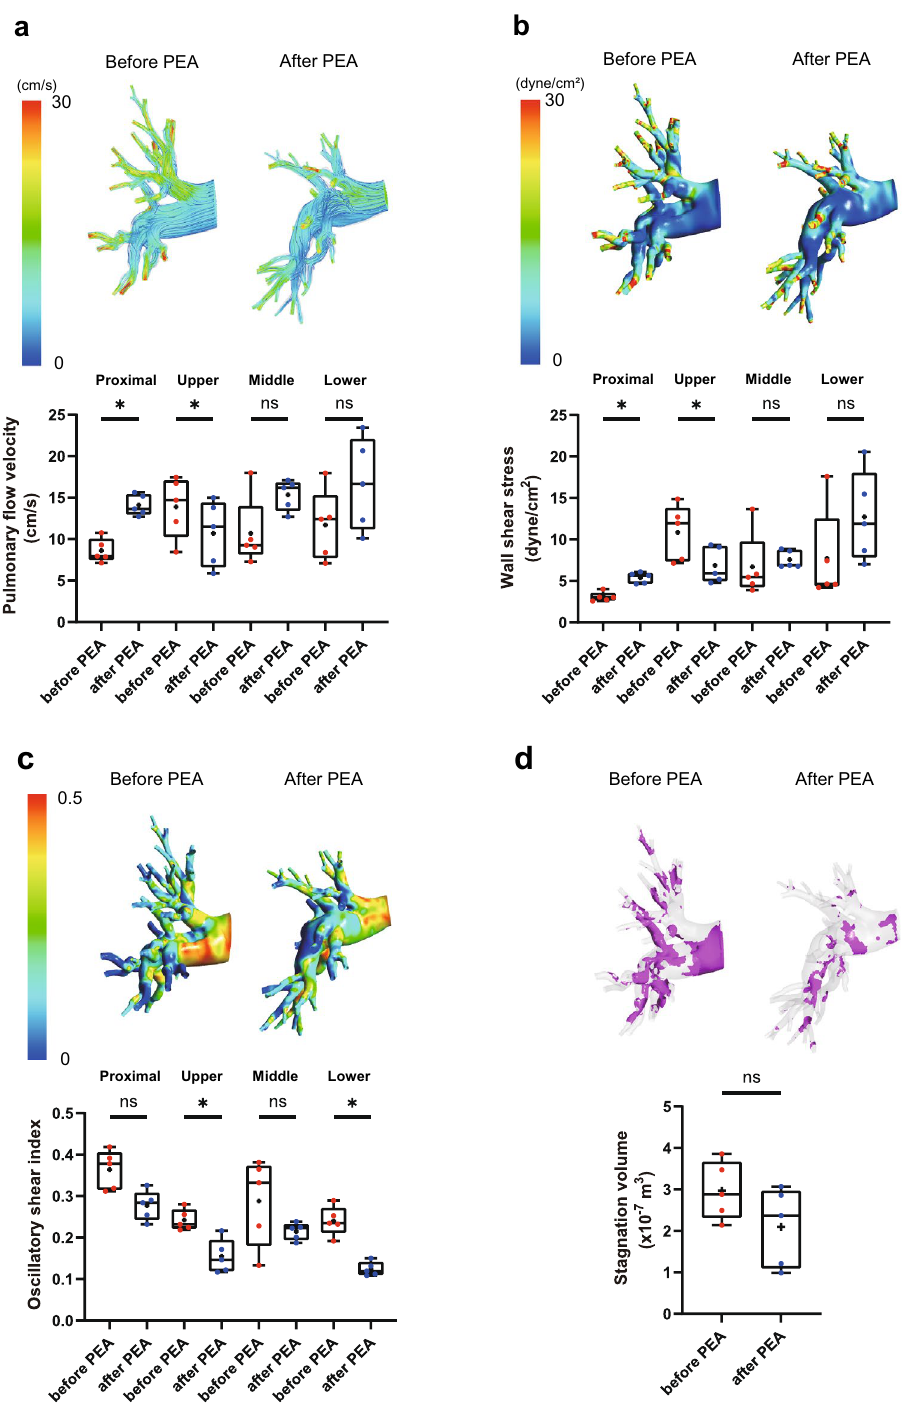
Figure 4. Pulmonary blood flow dynamics before and after PEA. Pulmonary flow velocity ( a ), wall shear stress ( b ), oscillatory shear index ( c ), and blood stagnation volume ( d ) were simulated using CFD in the pulmonary arteries of patients in comparison of before and after PEA. Stagnation was defined as a flow velocity < 0.01 m/s. Data are presented as median (interquartile range). Cross indicates mean. The numbers in each box plot indicate the sample size for each group. *p < 0.05 compared to before PEA; ns, not significant; PEA, pulmonary